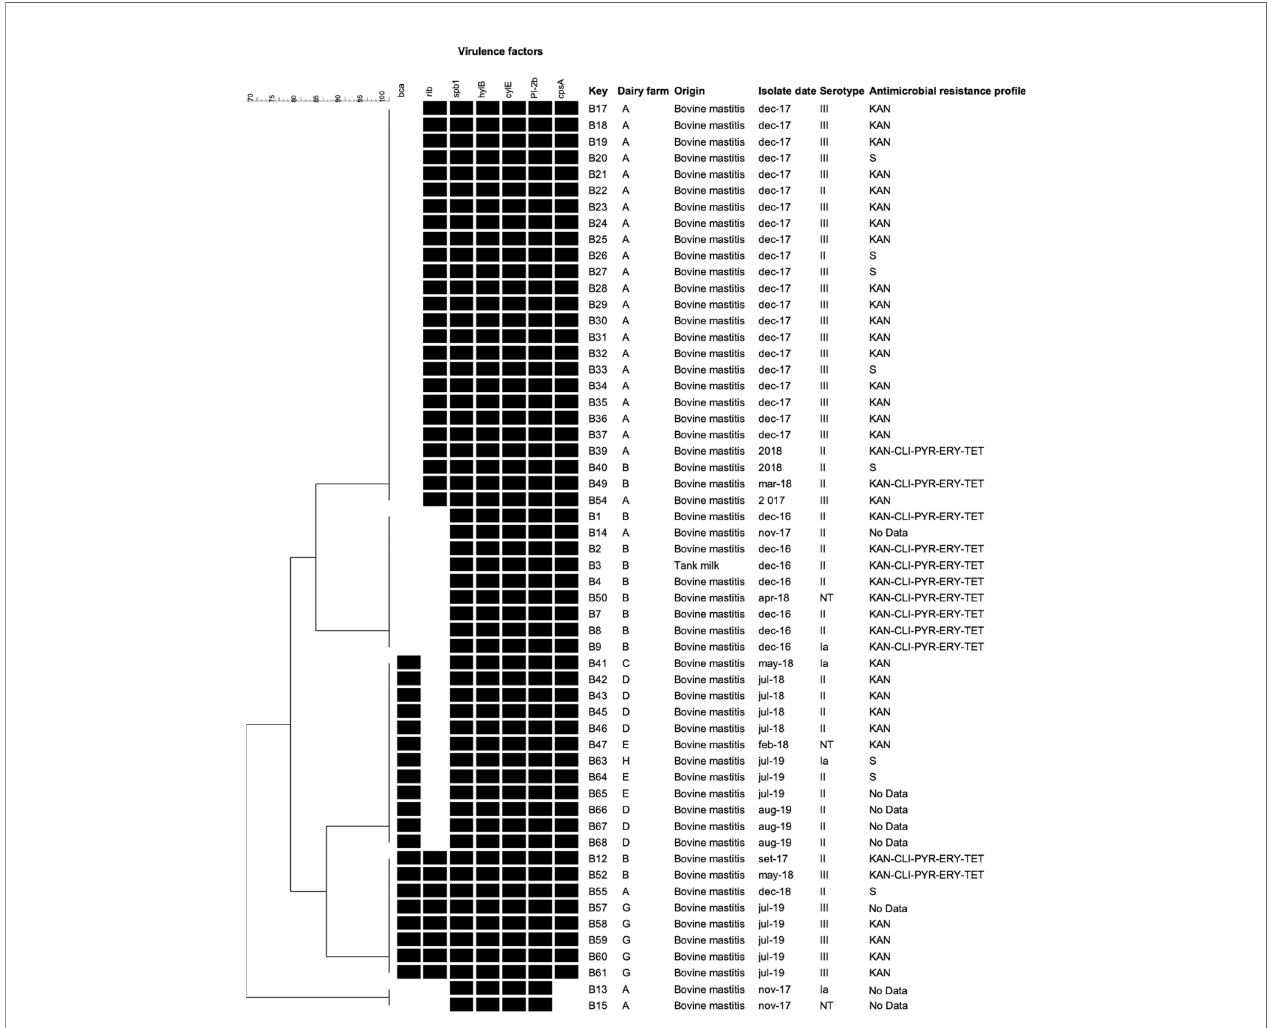
FIGURE 1 | Cluster analysis of Streptococcus agalactiae isolated from dairy cattle with mastitis in Argentina based on virulence-associated genes pro fi les. The presence (black) or absence (white) of genes, the isolate name, dairy farm, origin, isolation date, and serotype of the isolates are shown. The antimicrobial resistance pro fi les are indicated on the right. NT, non-typeable. Genes not found in any of the studied isolates: bac, lmb, hvgA, PI, PI-2a , and scpB . S: susceptible to all tested antimicrobial